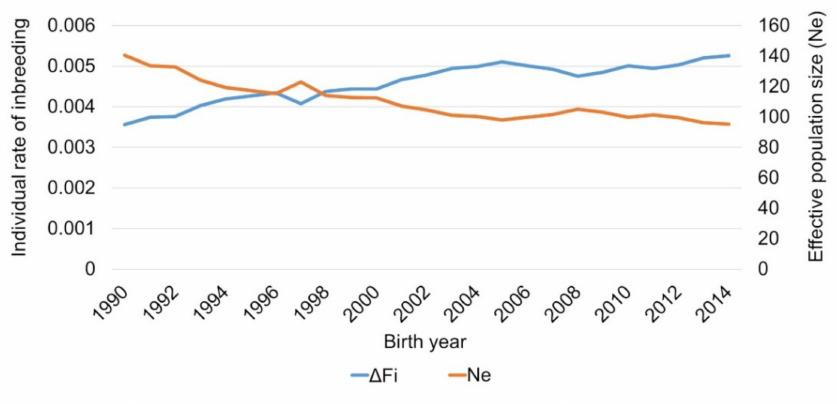
Figure 2. Effective population size (N e ) and individual rate of inbreeding per generation ( ∆ F i ) for German Brown born between 1990 and